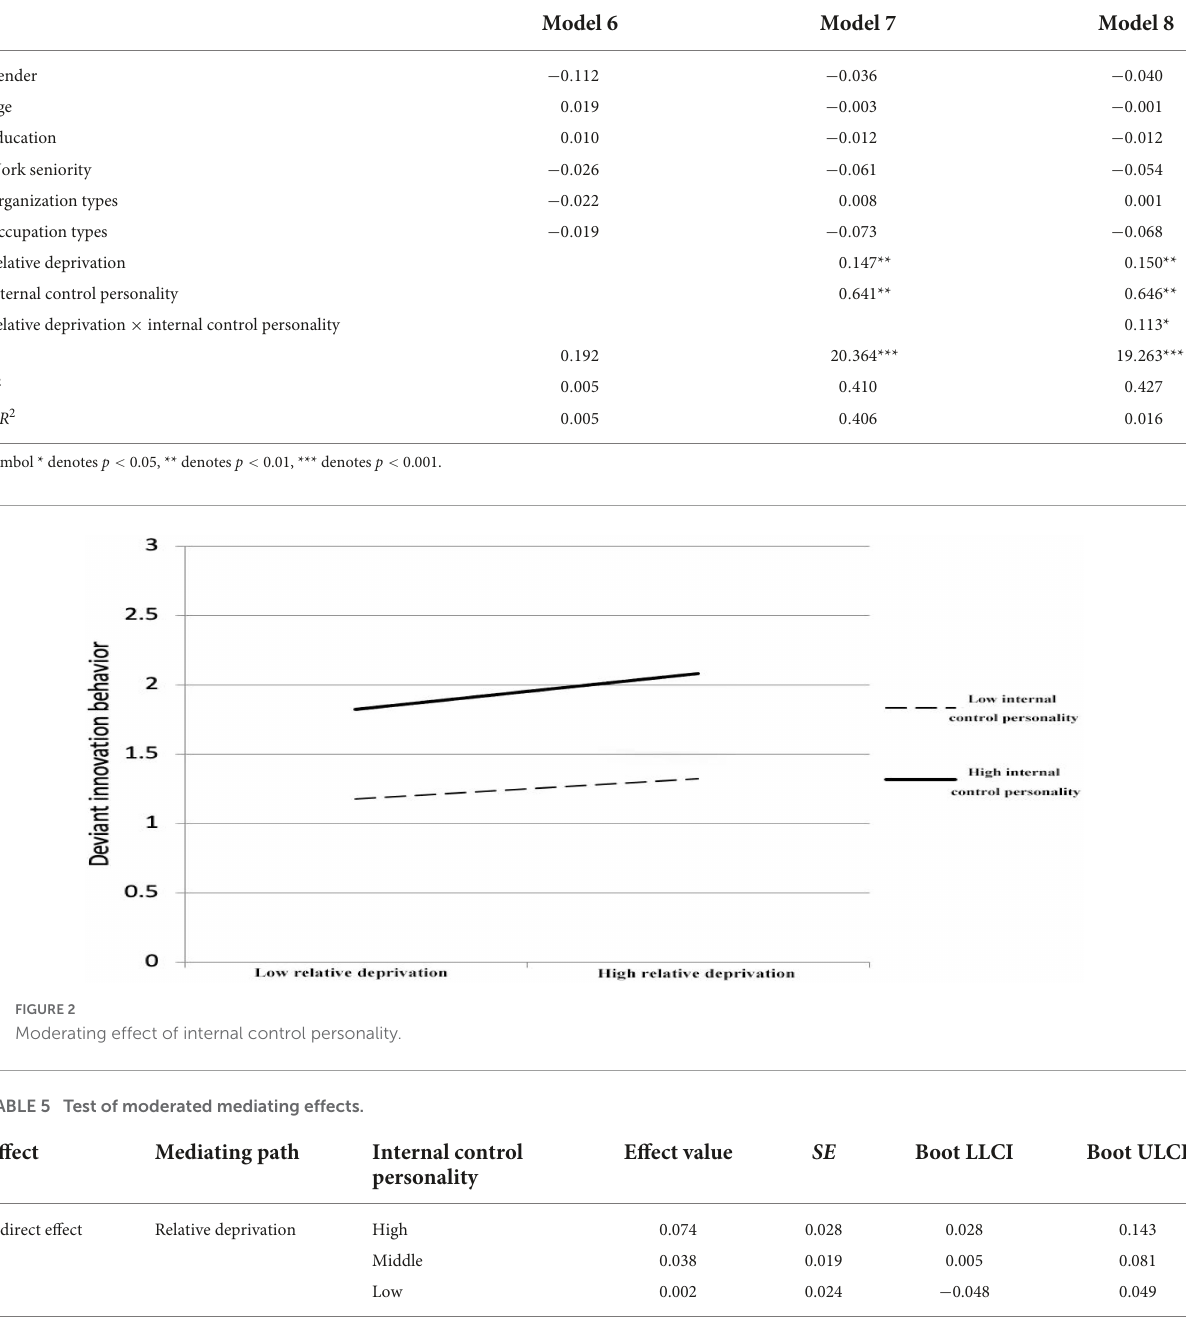
TABLE 4 Moderating effect of internal control personality ( n = 243).